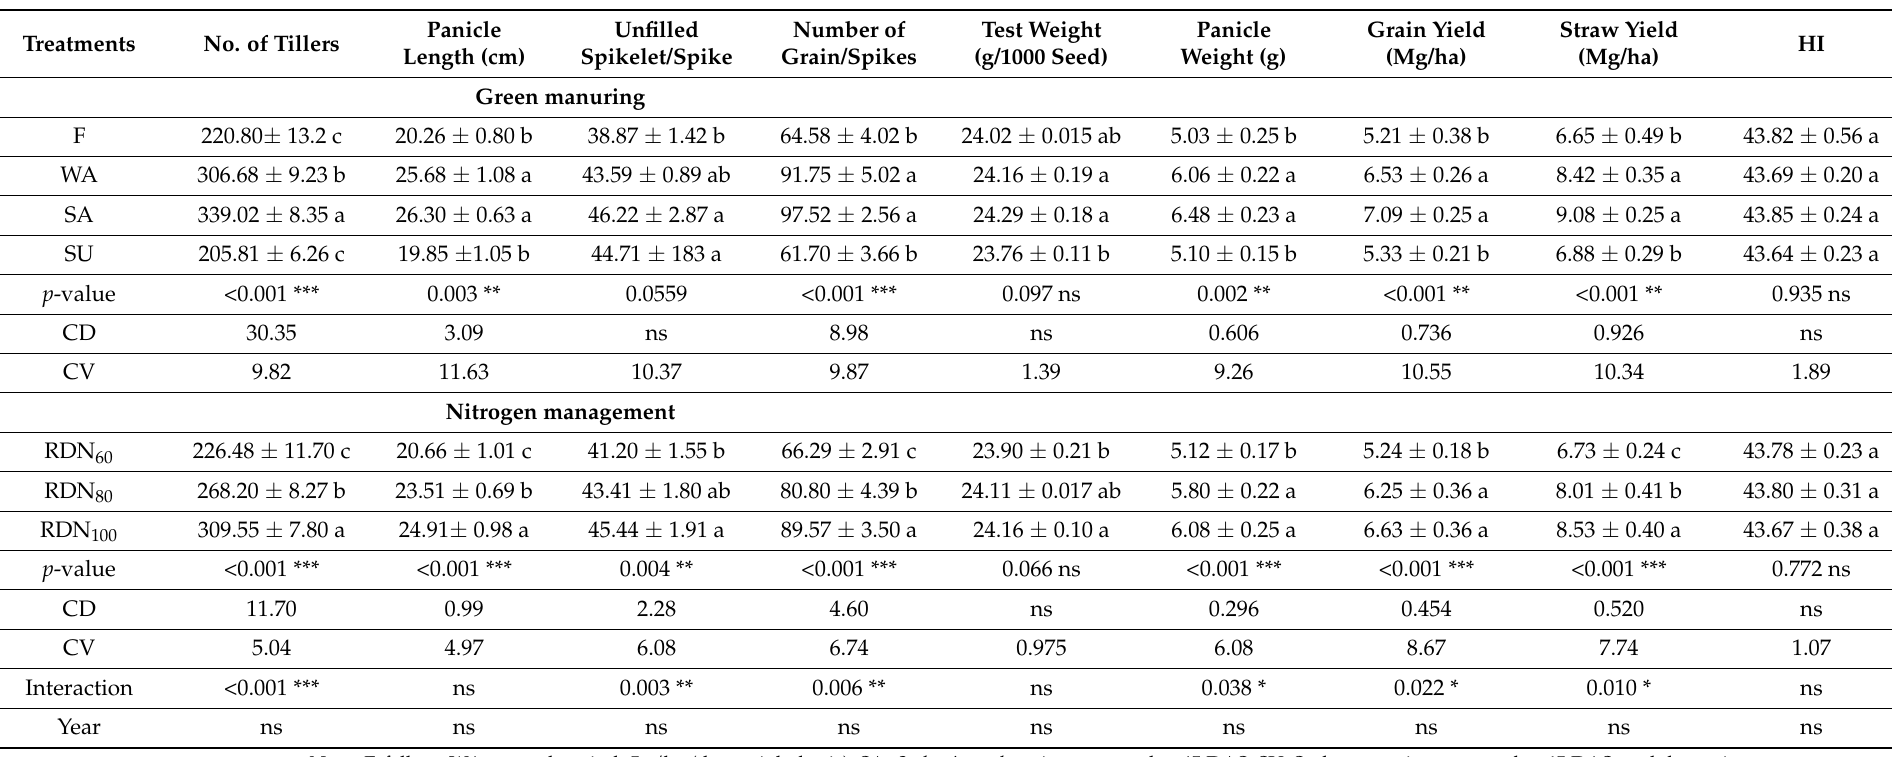
Table 2. Effect of summer green manuring and nitrogen management on yield attributes of unpuddled transplanting of hybrid rice.